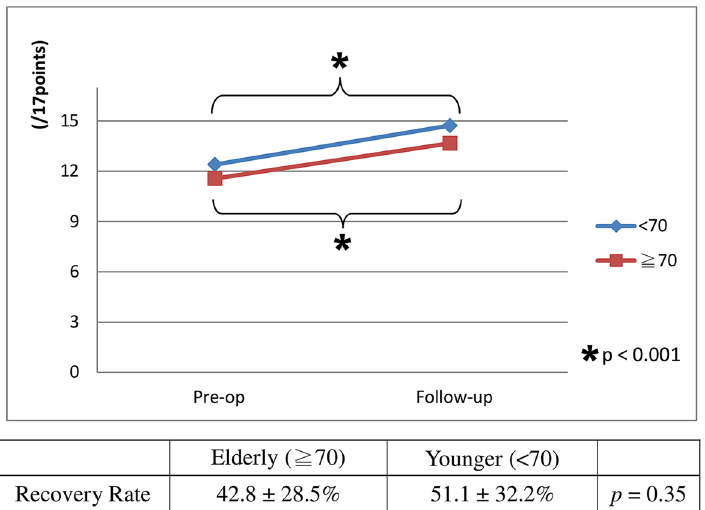
Figure 2. The clinical outcome of multilevel ACDF for degenerative cervical myelopathy as evaluated by Japanese Orthopaedic Association (JOA) score. The JOA score improved significantly in both